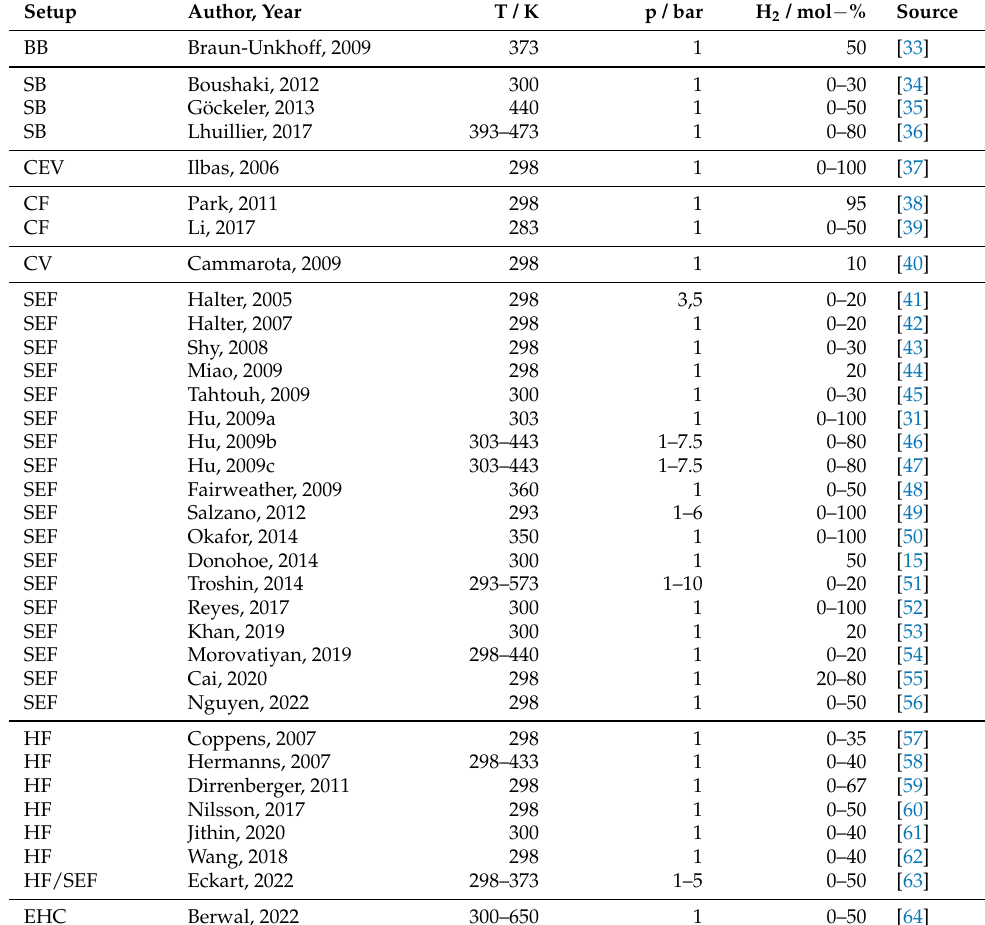
Table 2. Overview of the studies that investigated the laminar burning velocity for CH 4 /H 2 mixtures. Column H 2 represents the H 2 mole fraction in the fuel mixture of CH 4 /H 2 . BB: Bunsen burner; SB: slotburner; CEV: Cardiff explosion vessel; CF: counterflow; CV: combustion vessel; SEF: spherical